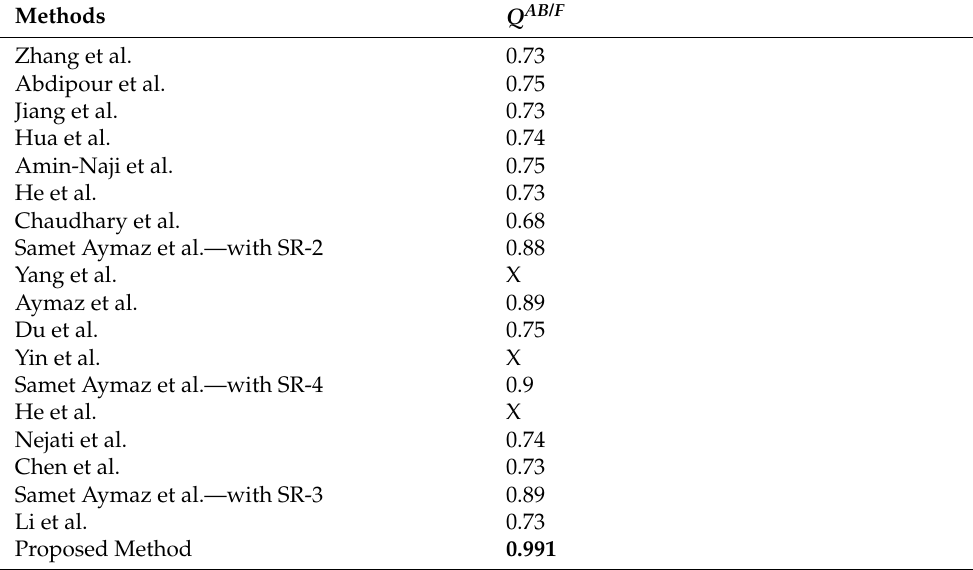
Table 27. The outcomes for the lab image and comparisons with existing techniques in the literature ([27]).